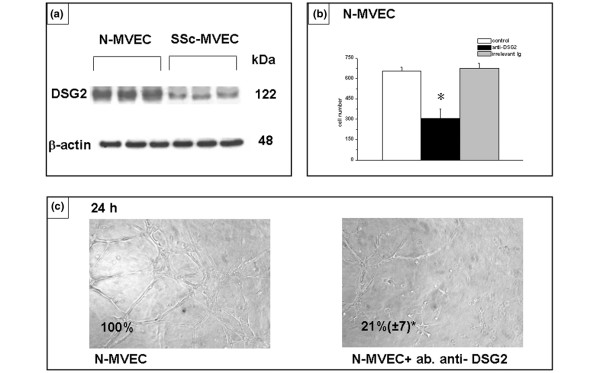
Expression and role of desmoglein (DSG)2 in endothelial cell invasion and capillary morphogenesis. (a) Western blotting of 60 μg protein from cell lysates of microvascular endothelial cells (MVECs) from normal subjects (N-MVECs) and patients with systemic sclerosis (SSc-MVECs) with anti-DSG2 antibodies. Each lane represents western blotting of MVECs obtained from a single patient. Actin was used as an internal reference standard. Numbers on the right represent the molecular weight expressed in kDa. (b) Effect of anti-DSG2 antibodies (3 μg/ml) on matrigel invasion of N-MVECs. The effect of irrelevant mouse IgG is also shown. Numbers on the x-axis refer to the total number of cells migrated through the matrigel after 6 hours. Data are the mean ± standard deviation of three experiments performed in triplicate in three N-MVEC lines. The asterisk indicates that values are significantly different from the values of control (p < 0.05). (c) Effect of anti-DSG2 antibodies on capillary morphogenesis of N-MVECs. See the legend to Figure 1 for experimental details. Irrelevant mouse IgG gave results similar to control untreated N-MVECs (not shown). These data are representative of three different experiments performed on three N-MVEC cell lines (100× magnification). Numbers reported within each panel indicate the percent of the photographic field occupied by cells ± standard deviation. The asterisk indicates that values are significantly different from the values of control N-MVECs at 6 hours after plating on Matrigel (p < 0.05).